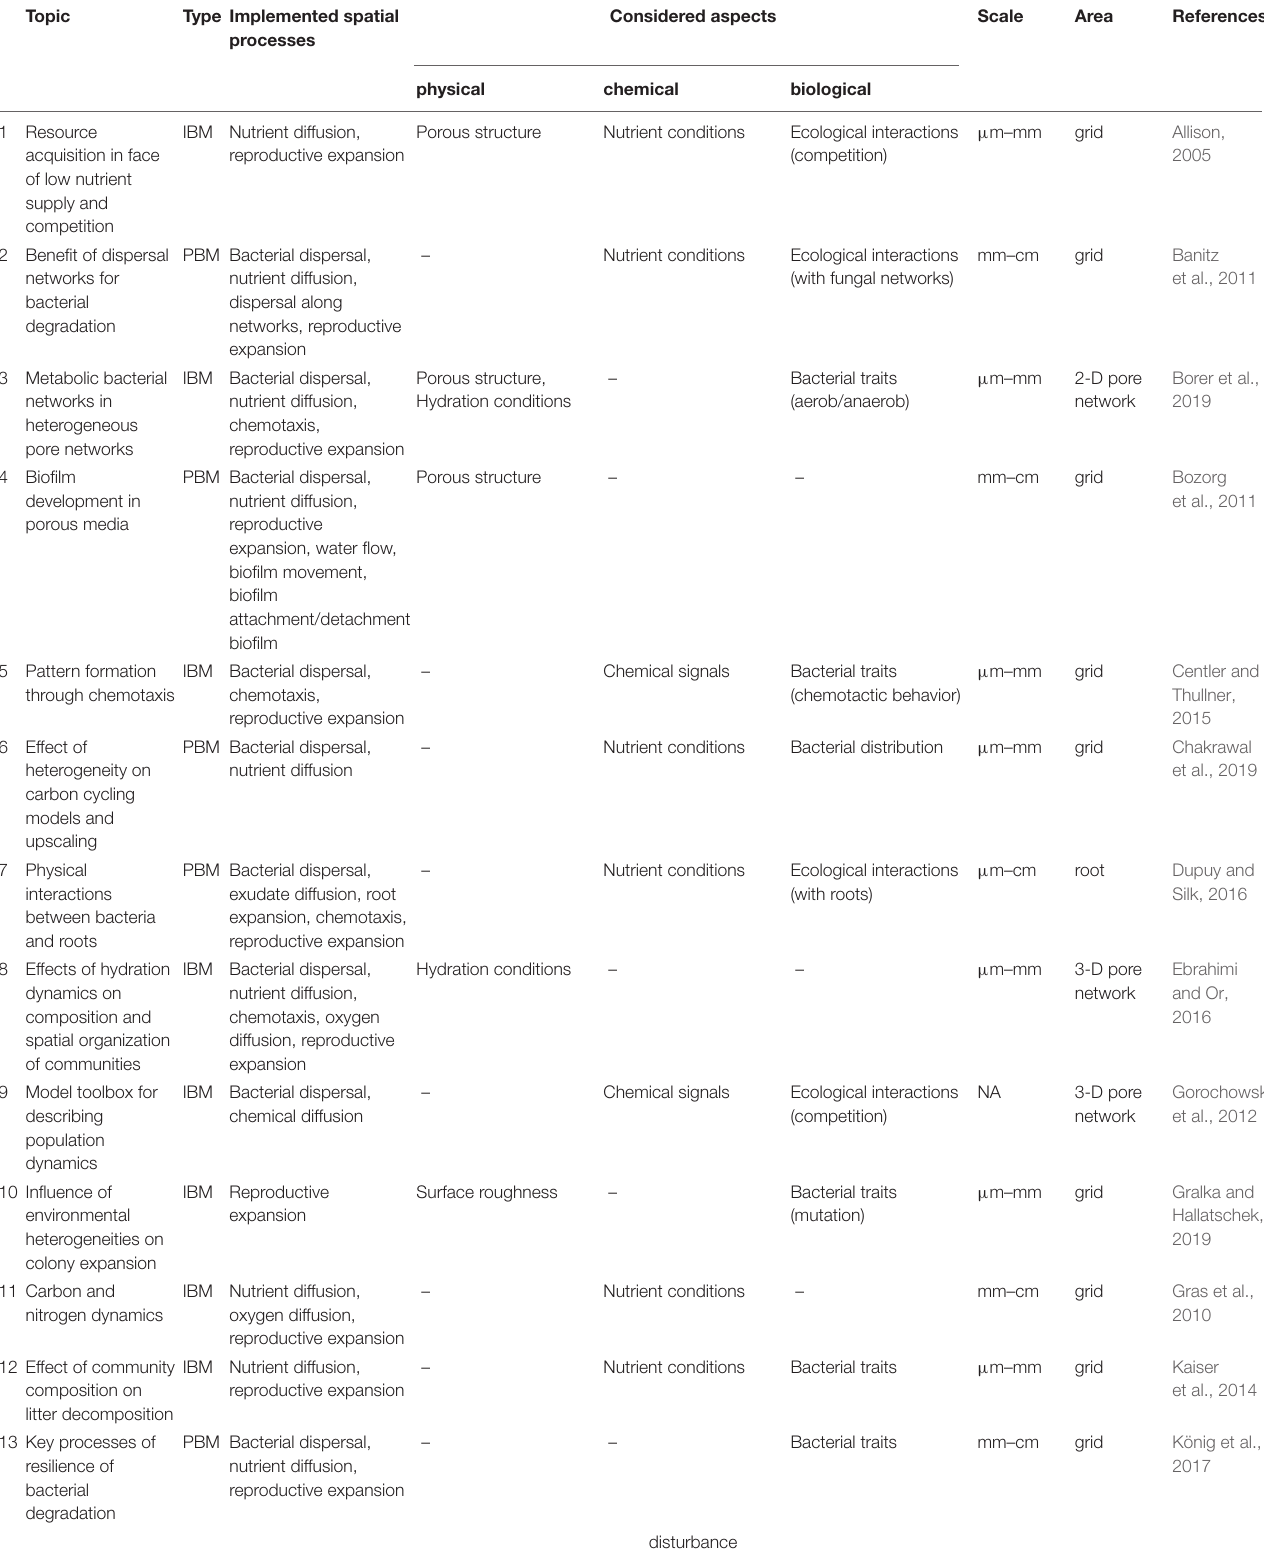
TABLE 1 | Overview of different spatially explicit microbial models, thematic focus, implementation details and considered physical, chemical, and biological aspects (IBM, individual-based model; PBM, population-based model).